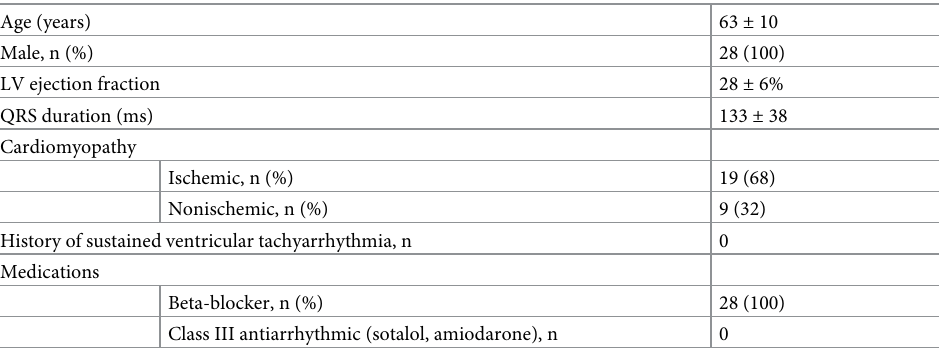
Table 1. Patient